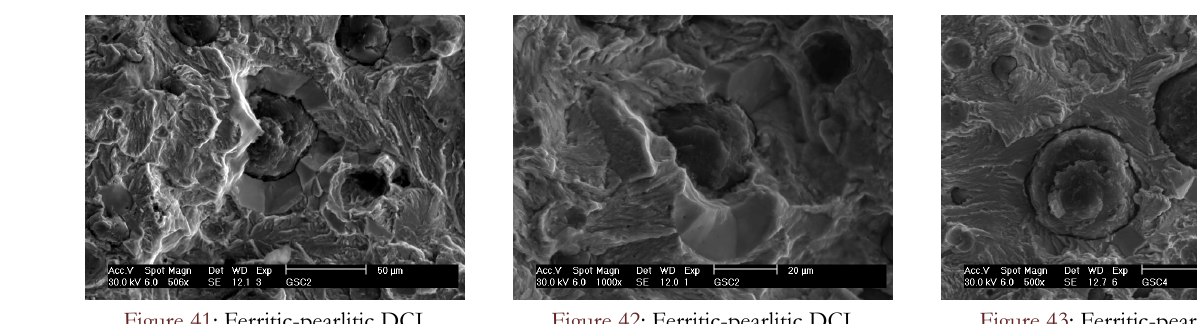
Figure 40: Pearlitic DCI (R = 0.1,  K = 16 MPa √ m).